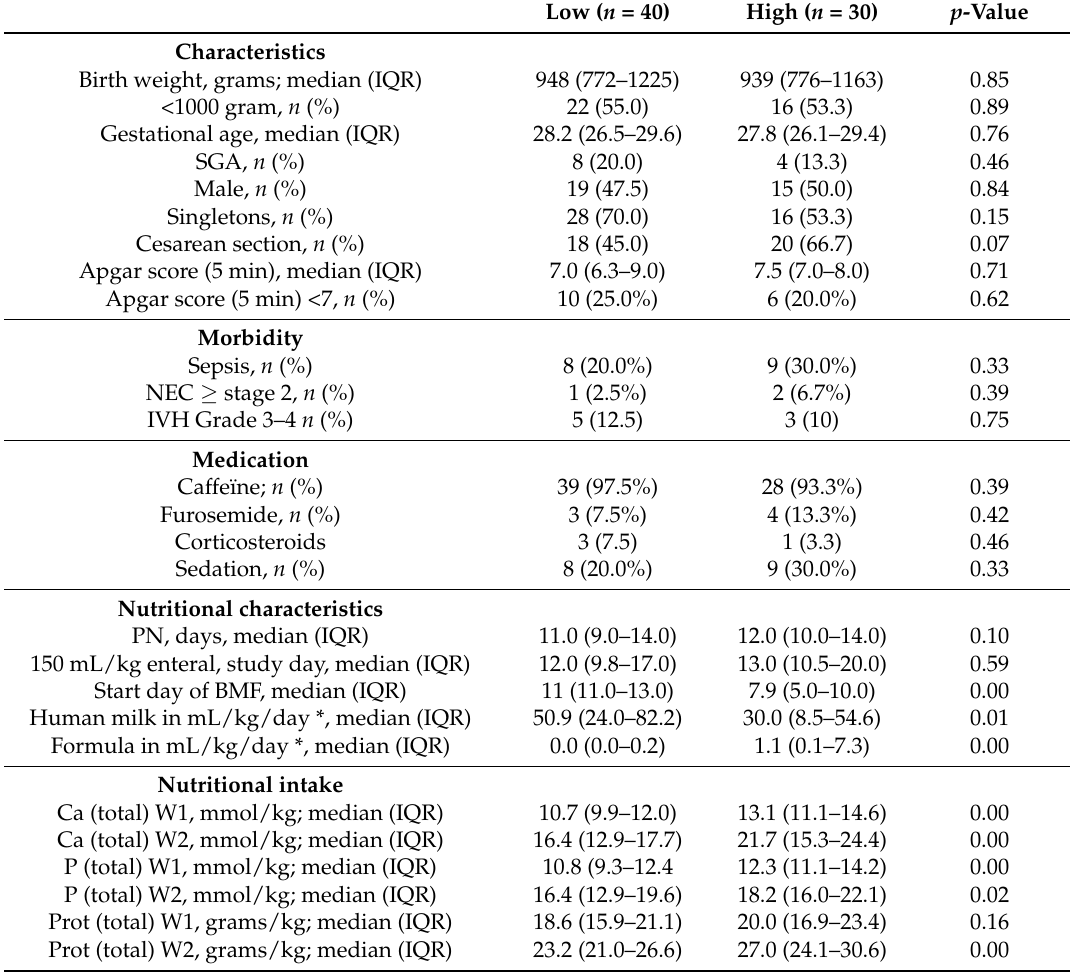
Table 1. Patient characteristics, morbidity, medication, and nutritional